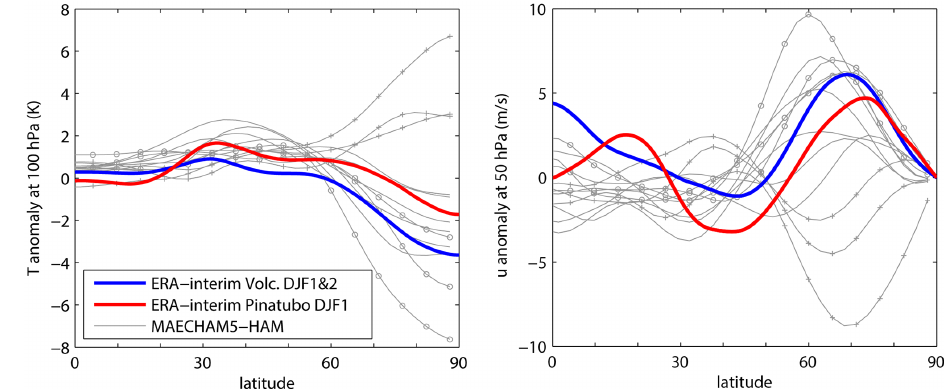
Figure 3. First post-eruption NH winter (DJF) anomalies of (left) temperature at 100hPa and (right) zonal wind at 50hPa for the 12-member MAECHAM5-HAM Pinatubo ensemble of Toohey et al. (2011) (grey lines). Ensemble members constituting the strong and weak vortex composites (SVC and WVC) as defined in the main text are marked by circles and crosses, respectively. For comparison, ERA-Interim anomalies based on a composite of the two winters after the eruptions of El Chichón and Pinatubo (blue), and the single winter after the Pinatubo eruption (red) are also